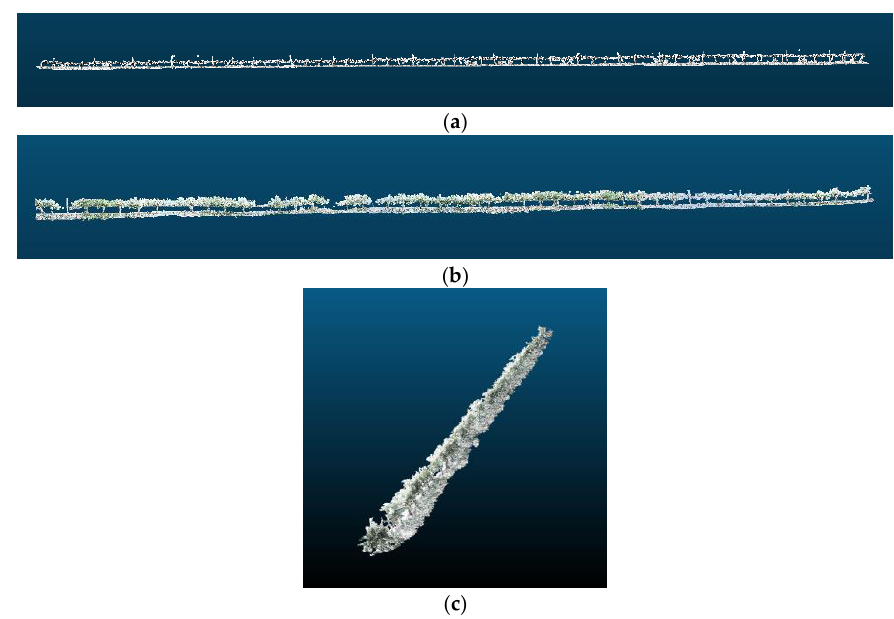
Figure 17. ( a – c ) 3D reconstruction of vineyards in Figure 16 after the drift has been removed.